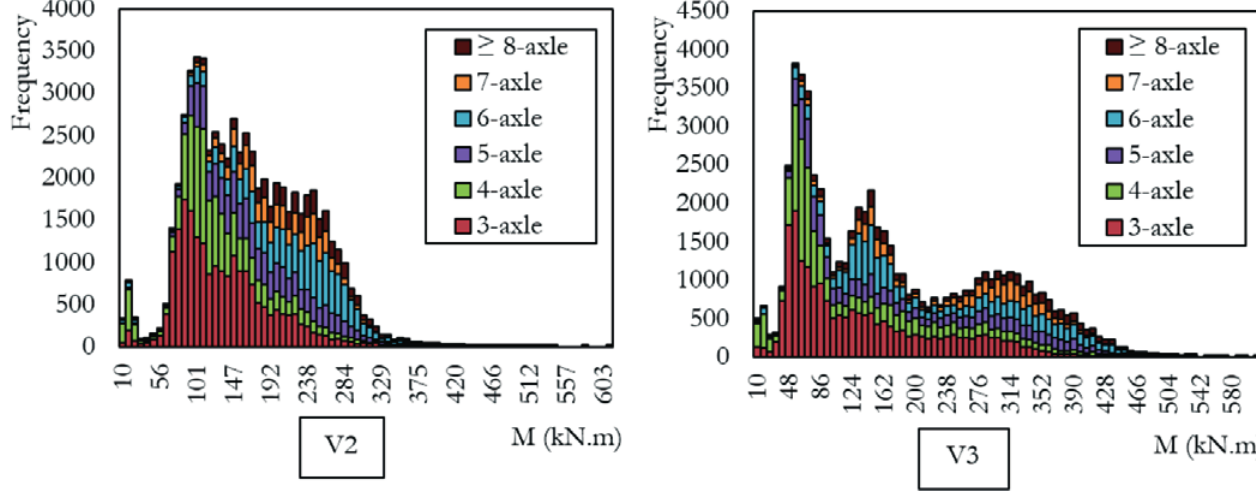
Bending moments histogram for girders V2 and V3 by means of vehicle class